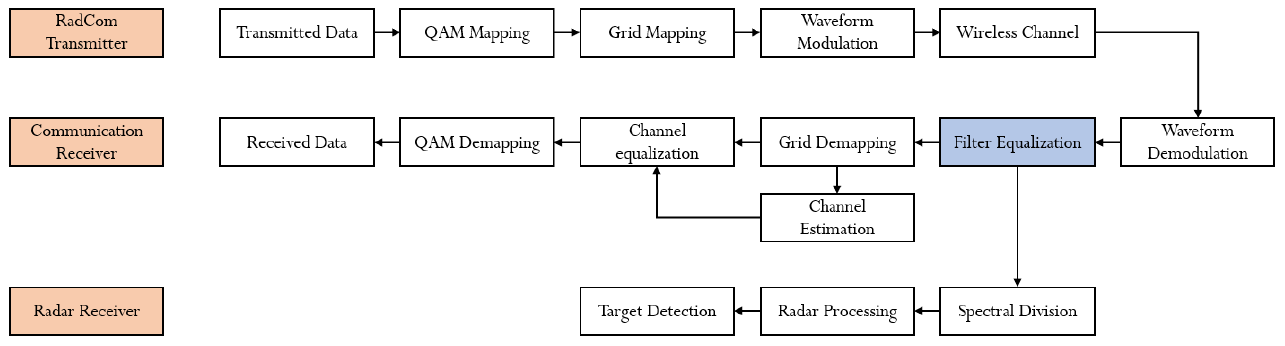
Figure 2. RadCom system